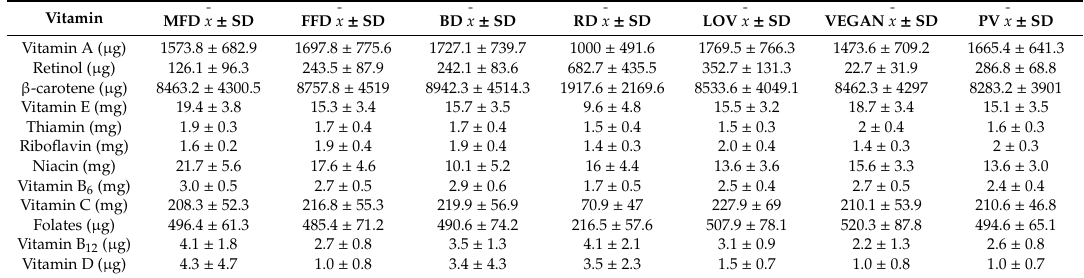
Table 8. Comparison of the average content of vitamins in the analyzed diets.